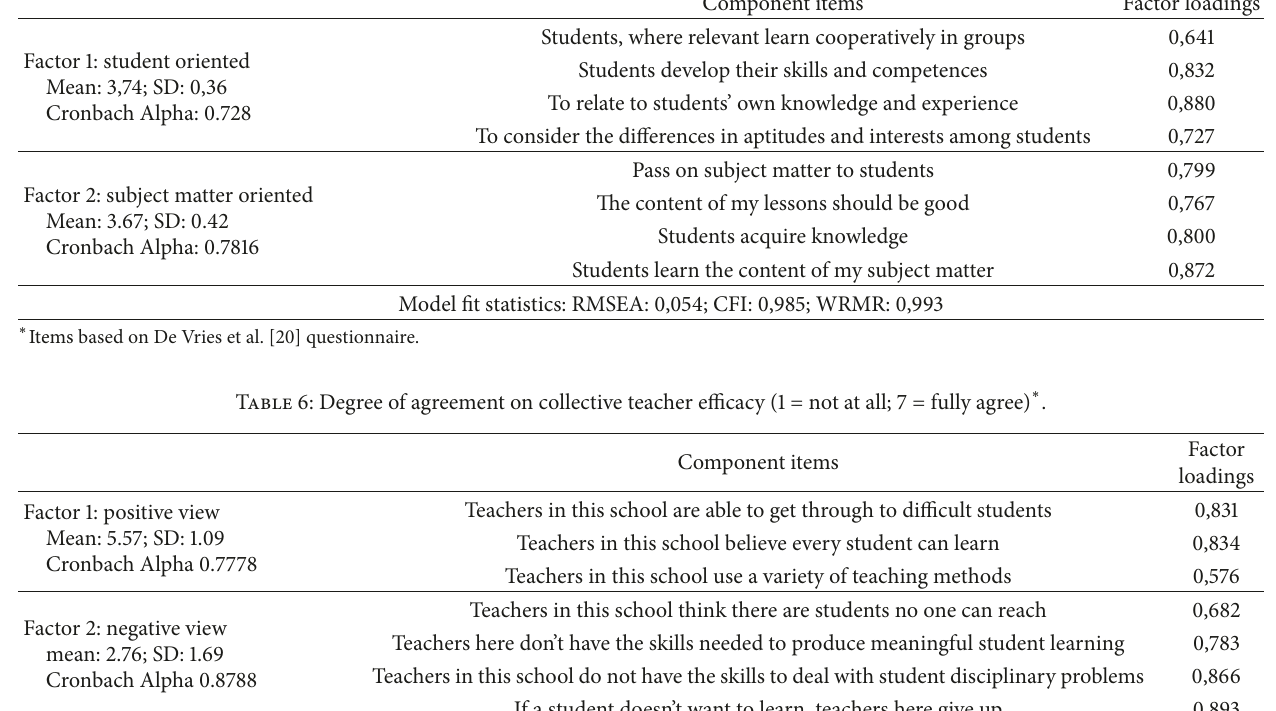
Table 5: Teacher beliefs about the focus of teaching for learning (1 = not important; 4 = very important ) ∗ . Component items